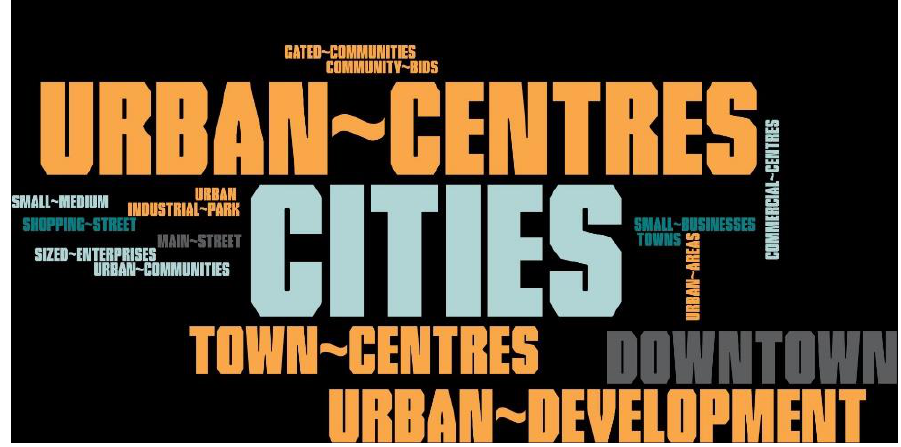
Figure 10 . Word cloud, extracted from keywords, that fit in dimension “BIDs: various types and places of intervention” .